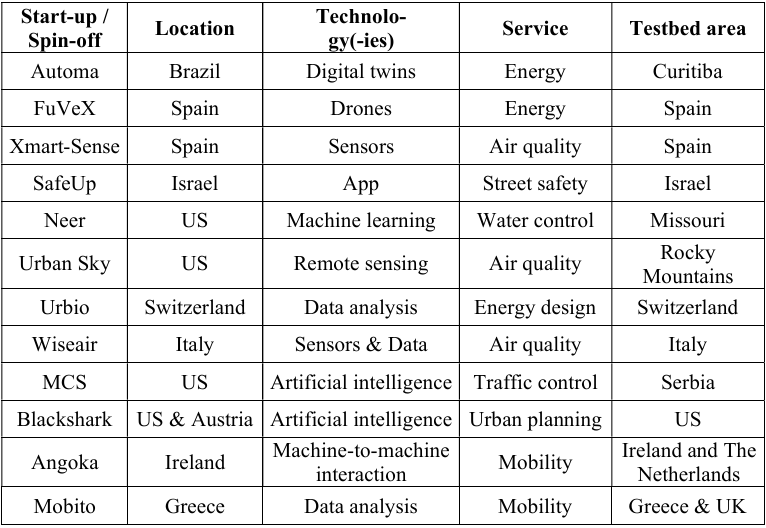
Table 1. Key characteristics of main case